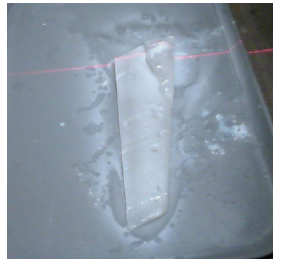
Figure 8. Results of 3D reconstruction and comparison of 3D models obtained in visible and thermal